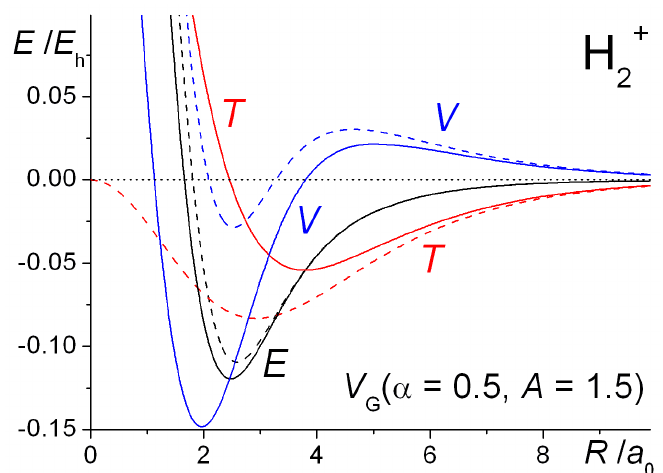
Figure 10. Energies of H 2 + computed with Gaussian potentials ( α = 0.5, A = 1.5). Results with optimized and fixed (atomic) exponents are shown with full and dashed lines respectively. Total, kinetic and potential energies are shown in black, red, and blue,